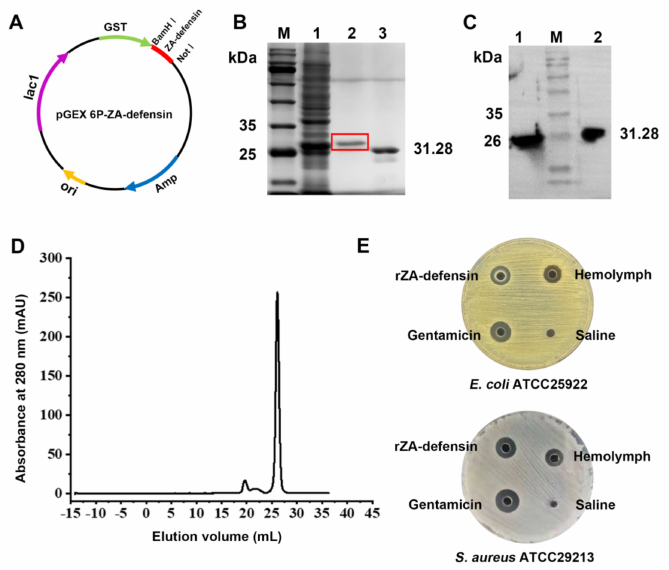
Figure 1. Expression and verification of recombinant Z. atratus defensin. ( A ) Construction of pGEX 6P-ZA-defensin. The gene codes mature Z. atratus defensin was cloned into pGEX 6P-1 with BamH I and Not I to construct recombinant plasmid pGEX 6P-ZA-defensin. ( B ) SDS-PAGE of recombinant ZA-defensin (rZA-defensin) expression. M: marker (10–180 kDa); 1: expression product of rZA- defensin induced by IPTG; 2: purified rZA-defensin; 3: GST-tag cut from rZA-defensin. ( C ) Western blotting analysis of purified rZA-defensin. 1: GST-tag cut from rZA-defensin defensin; M: marker